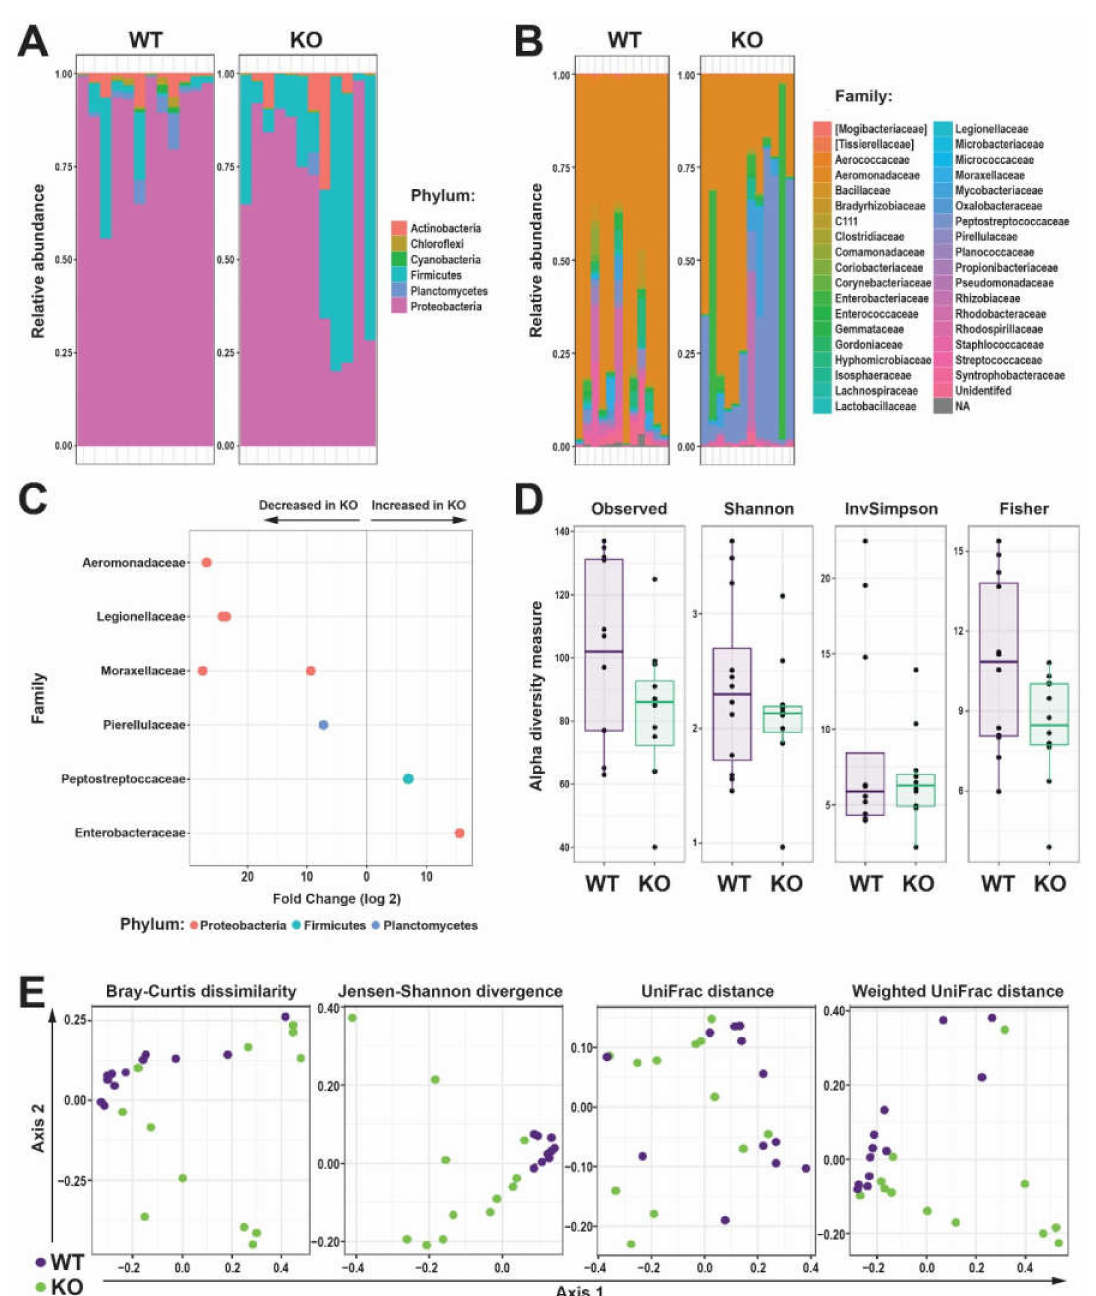
Figure 3. Effect of Il-2r γ c.a ablation on intestinal microbiota. ( A , B ) Relative abundance of bacterial Amplicon sequence variants (ASVs) identified to the taxonomic level of phylum ( A ) and family ( B ) in the intestinal microbiome of individual WT (purple) and KO (green) zebrafish. ( C ) Differential abundances of bacterial family statistically different ( p < 0.05) between WT and KO zebrafish, with the direction of change indicated. ( D ) Alpha diversity of WT and KO zebrafish intestinal microbiome displaying Observed, Shannon, InvSimpson, and Fisher’s indices as box and whisker plots. ( E ) Beta diversity of WT (purple) and KO (green) zebrafish intestinal microbiome displaying Bray-Curtis dissimilarity, Jensen-Shannon divergence, Unifrac, and Weighted Unifrac of log-transformed relative abundances ordination plots, with each dot representing an individual fish ( n = 12 each